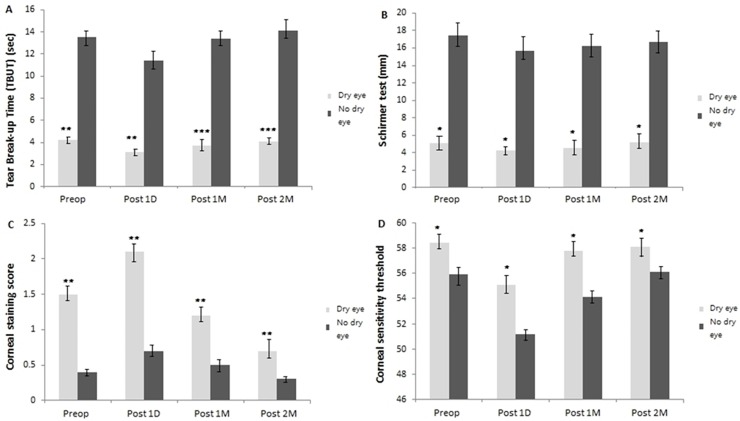
Changes in lacrimal tear and ocular surface parameters preoperatively, 1 day, 1 and 2 months postoperatively from preoperative value.(A) Change in TBUT (sec) from preoperative value. TBUT was significantly short in the dry eye group at 1 day, 1 and 2 months postoperatively compared to the no dry eye group (P <0.05). (B) Change in Schirmer I test (mm) from preoperative value. Schirmer I test value was significantly short in the dry eye group at 1 day, 1 and 2 months postoperatively compared to the no dry eye group (P >0.05). (C) Change in corneal staining score from preoperative value. There was a statistically significant decrease in the corneal staining score at 1 and 2 months postoperatively but the dry eye group showed higher score than the no dry eye group (P <0.05). (D) Change in corneal sensitivity threshold (mm) from preoperative value. Corneal sensitivity threshold slowly recovered to preoperative value at 1 and 2 months postoperatively but the dry eye group showed higher threshold level than the no dry eye group (P <0.05). Each value represents the mean ± standard error of the mean (SEM). Significance was evaluated with random-effects analysis of variance (ANOVA) model; p values of <0.05 were considered statistically significant. ***P < .001, **P < .01, *P < .05, using a linear mixed model with post hoc analysis, or generalized estimating equations model.